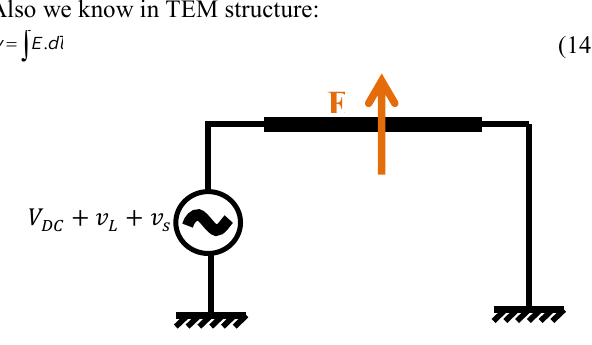
Figure 4: schematic of biased graphene in mixer application. The DC voltage is used for significant the suitable acting point and the large ac signal creates higher order terms